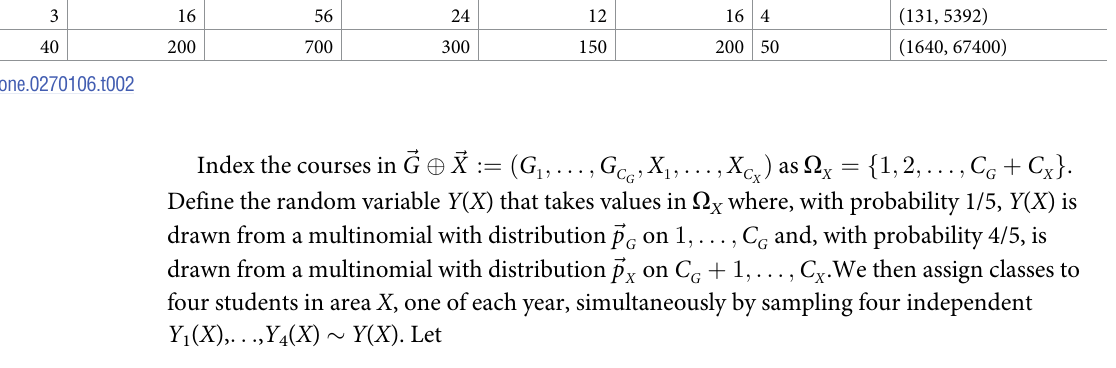
Index the courses in ~ G � ~ X : ¼ ð G